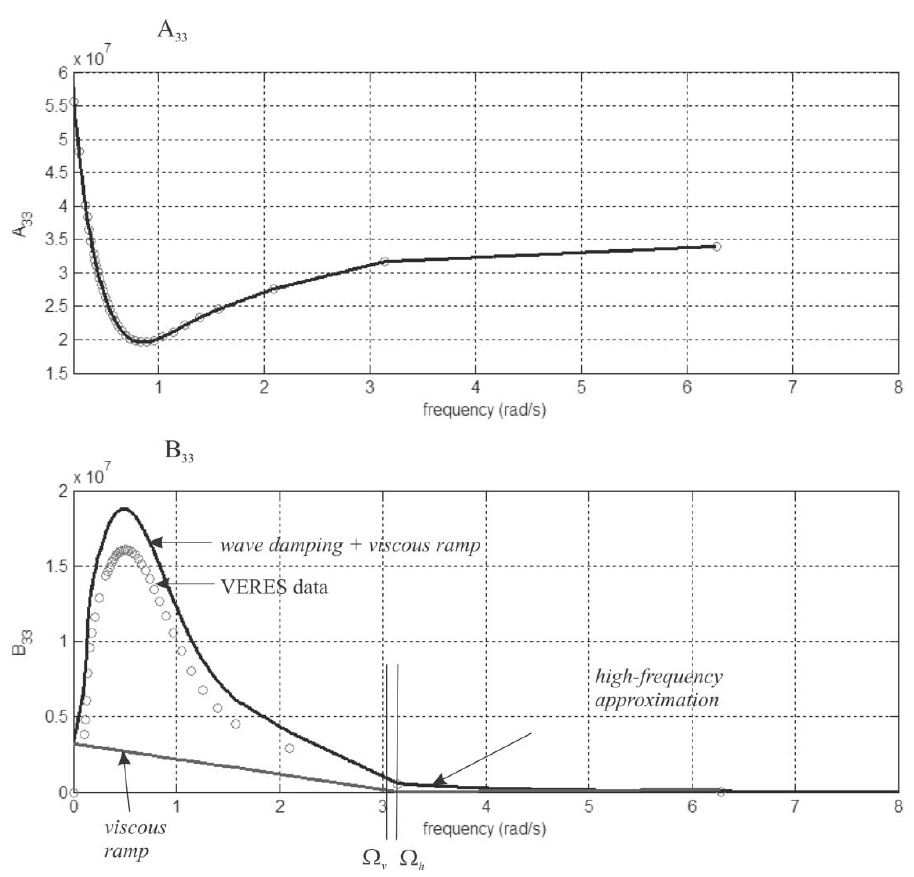
Figure 5. Experimental data showing the high-frequency approximation and viscous ramp